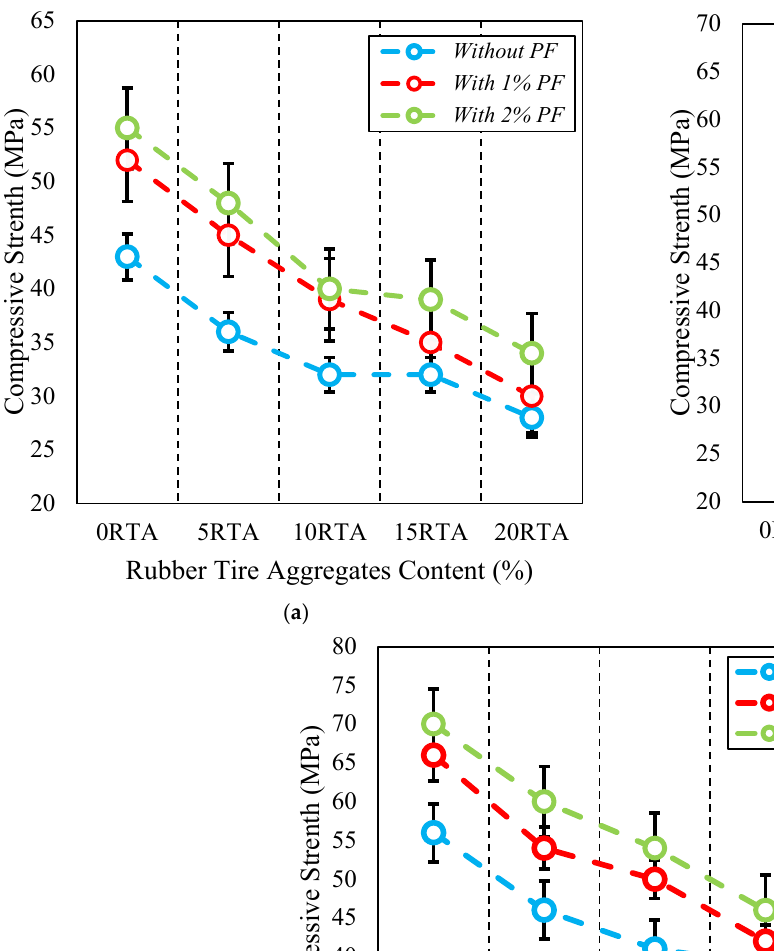
Figure 7. Failure in specimens due to tensile stress in the case of: ( a ) without RTA and PF; ( b ) without PF and with 20% RTA and; ( c ) with 2% PF and without RTA.